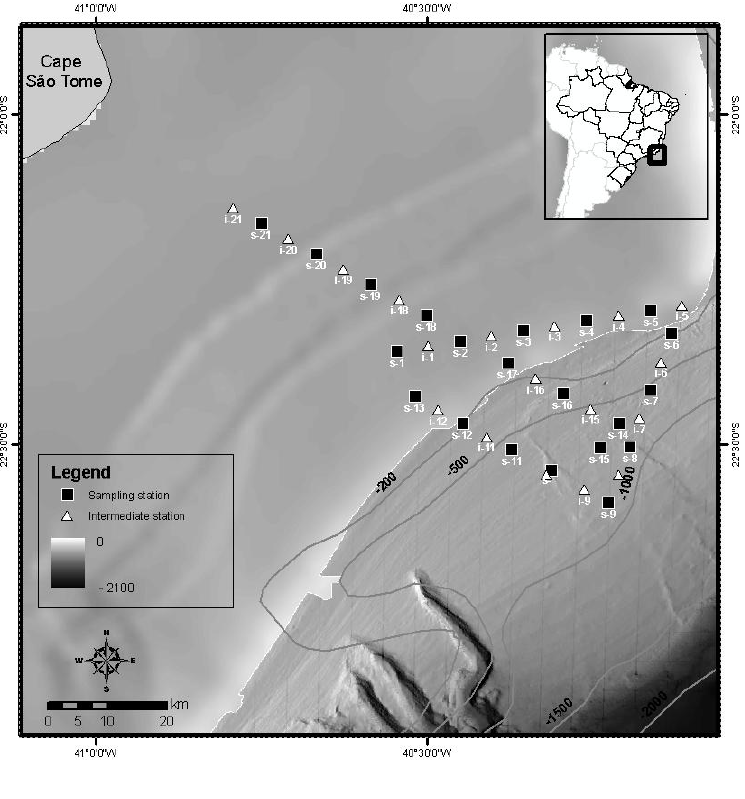
Figure 1. Study area and field stations occupied during November 2004 at the Brazilian Southeastern continental margin. Water sampling, above-water radiometry and lidar stations labeled with an “ s ” (black squares). Stations without water sampling labeled with an “ i ” (white triangles). Isobaths in